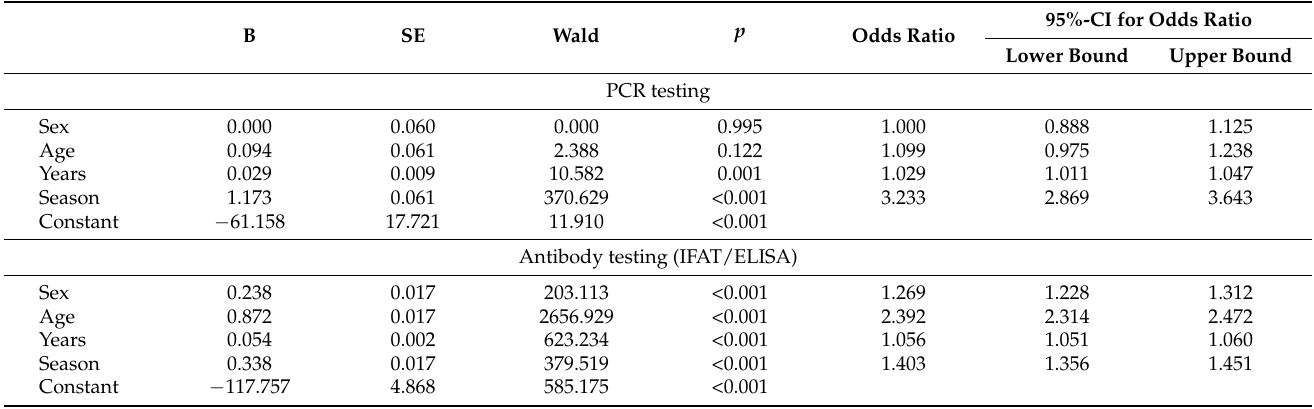
Table 3. Binominal logistic regression analysis in dogs tested for Anaplasma phagocytophilum by direct (PCR) and indirect detection methods (IFAT, ELISA) in 74973 dogs with known sex, age, years of testing, and months of testing from 2008 to 2020.